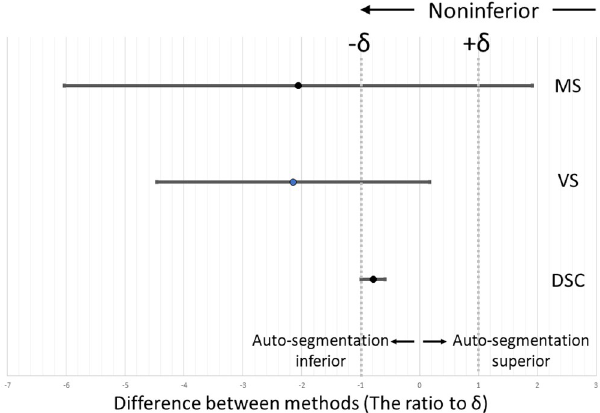
Fig 5. Noninferiority test comparing automatic and manual segmentation techniques using the 95% confidence interval of difference between two groups: δ : Equivalence margin (10% of average similarity score of manual segmentation performed by another